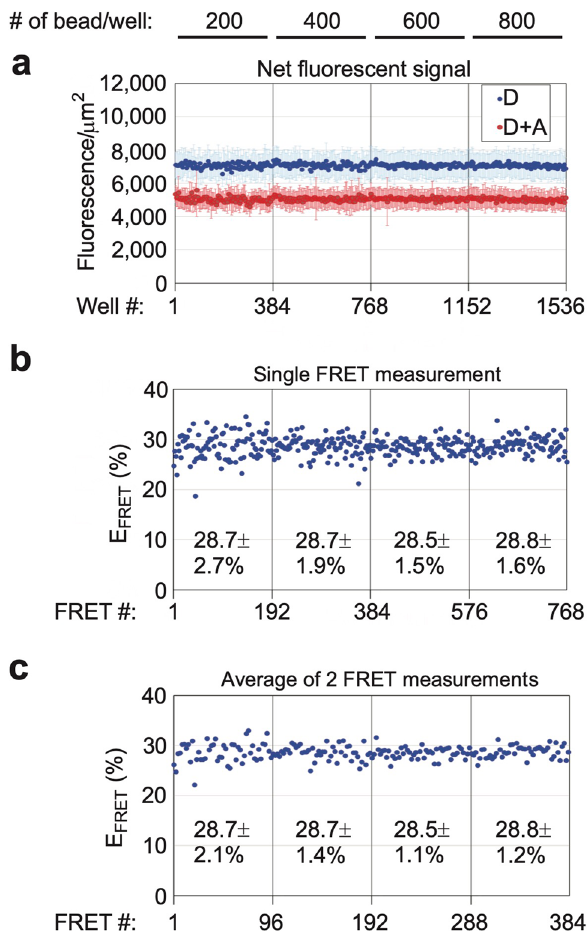
Figure 5. Bead titration in 1,536-well format. ( a ) Individual dots show mean fluorescence intensity ± SD for D and D + A samples bound to 17 µm beads in matched paired wells of a 1,536-well plate. Number of beads in each well is indicated at top. (1-image/well = 19% of total well area). ( b & c ) Individual E FRET values calculated from single D and D + A pair of wells ( b ), or average of two D and D + A pairs ( c ). Mean E FRET ± SD values